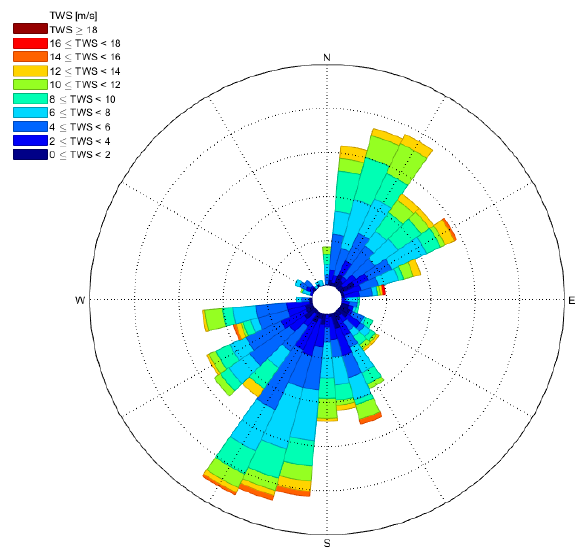
Figure 3. Wind scatter plot based on statistics from 2016 to 2018.